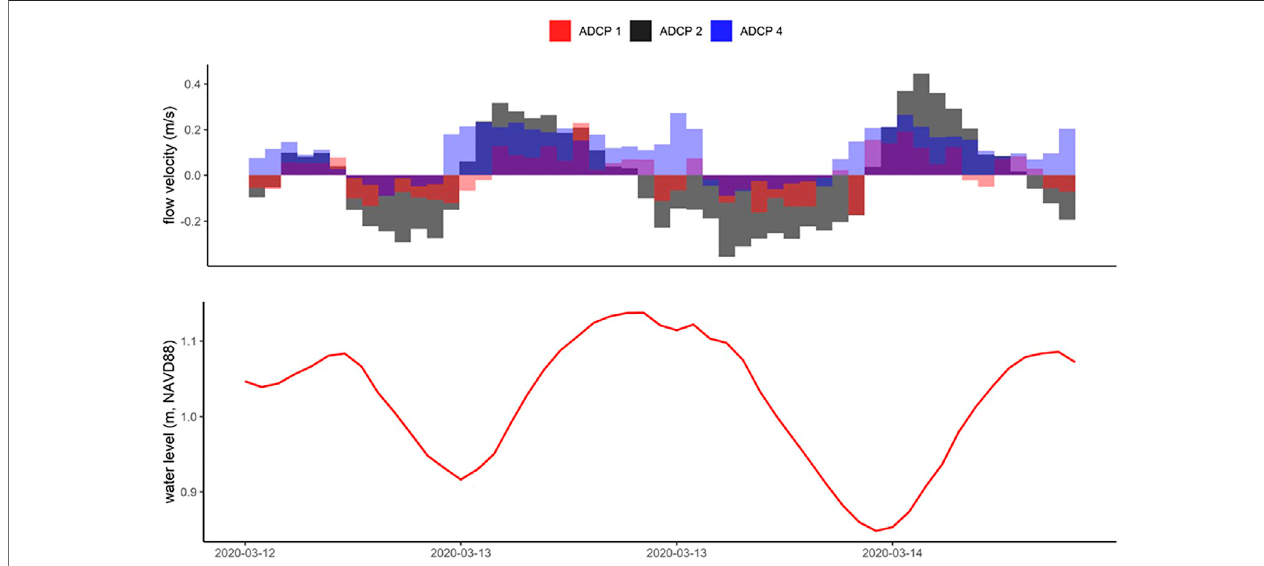
FIGURE 11 | Comparison of measured and modeled hydrodynamics at Carancahua inlet.